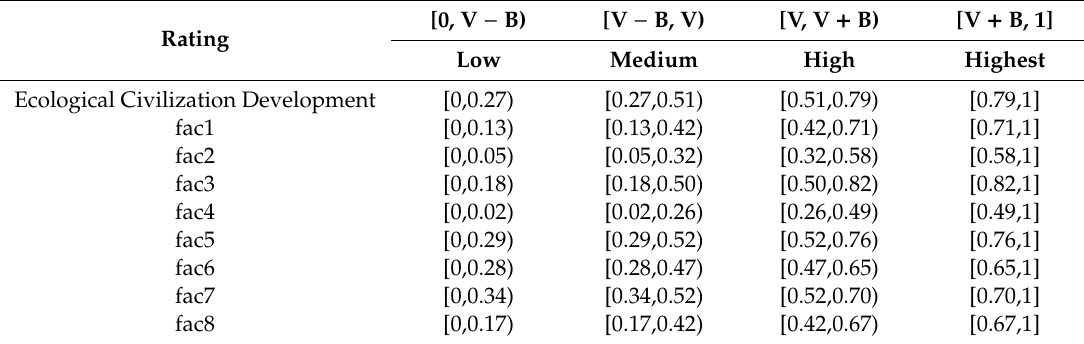
Table 6. Range of ratings through standard deviation method.